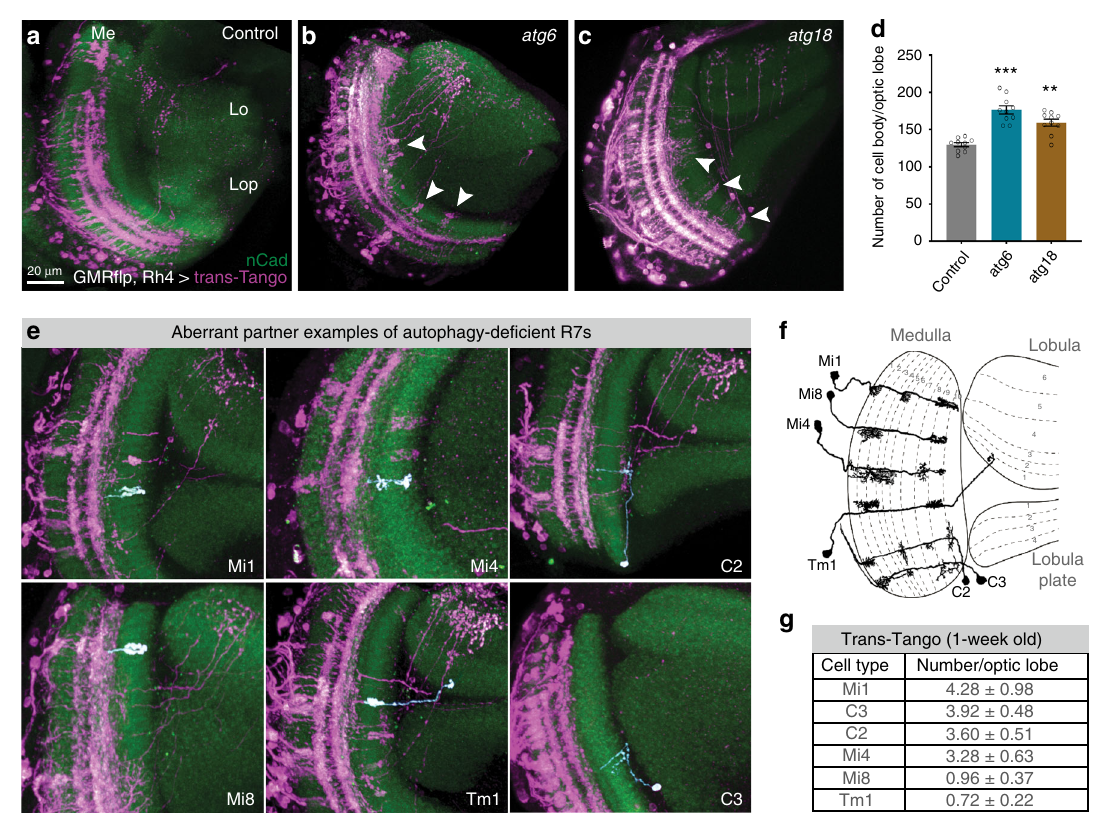
Fig. 3 Loss of autophagy leads to synaptic connections with aberrant neuronal partners. a – c Neurons postsynaptic to control ( a ), atg6 mutant ( b ), and atg18 mutant ( c ) R7s are labeled with trans -Tango (see Methods for full genotypes; magenta = postsynaptic neurons, green = CadN, Me = medulla, Lo = lobula, Lop = Lobula plate). Arrowheads show postsynaptic neurons labeled for autophagy-de fi cient R7s but not for control R7s. Repeated three to fi ve times independently with similar results. d Number of postsynaptic neurons per optic lobe for control, atg6 mutant, and atg18 mutant R7s based on trans - Tango-labeled cell body counts. n = 10 optic lobes per condition. One-way ANOVA and Tukey ’ s HSD as post-hoc test ** p < 0.01, *** p < 0.001. Error bars denote mean ± SEM. e Examples of aberrant neuronal partners of autophagy-de fi cient R7s, with individual neurons pseudo-colored in white. f Schematic of dendritic and axonal arborization of aberrant neuronal partners (redrawn and adapted based on Golgi impregnations from Fischbach and Dittrich 46 ). g Number of each aberrant neuronal partners per optic lobe from 1-week-old fl y brains. Note that only ∼ 10% of R7s are mutant for atg6 and trans -Tango labeling is dependent on synaptic strength between partners and progressively increase through age. See Methods for detailed Drosophila genotypes used to perform trans -Tango experiments. Source data are provided as a Source Data fi